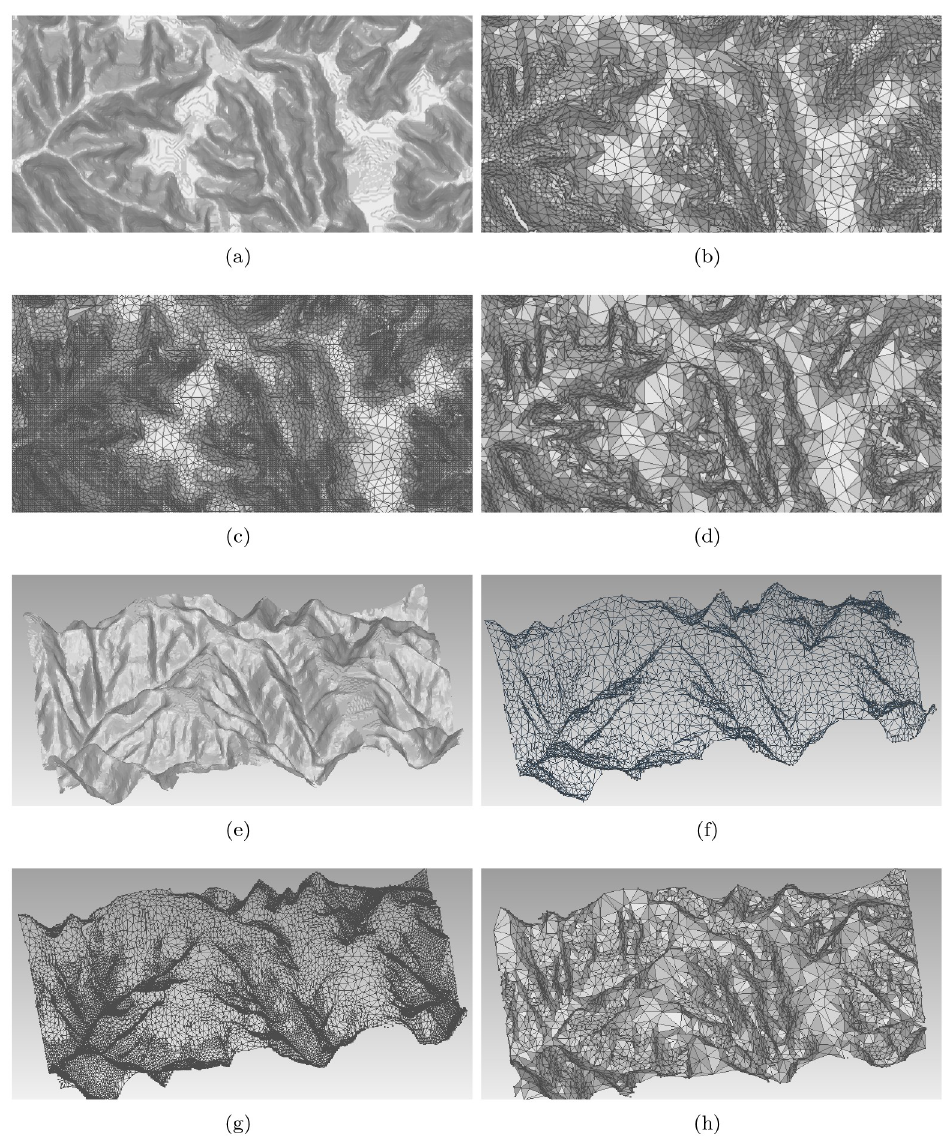
Fig 8. The reconstruction surfaces and mesh models. (a) is the original surface of a rugged DEM with steep slope; (b), (c) are the reconstructed surface using the 10% and 50% samples obtained by our method; (d) is the result of Poisson disk sampling; (e)-(h) are the mesh models corresponding to (a)-(d). Samples trade off the uniformity and